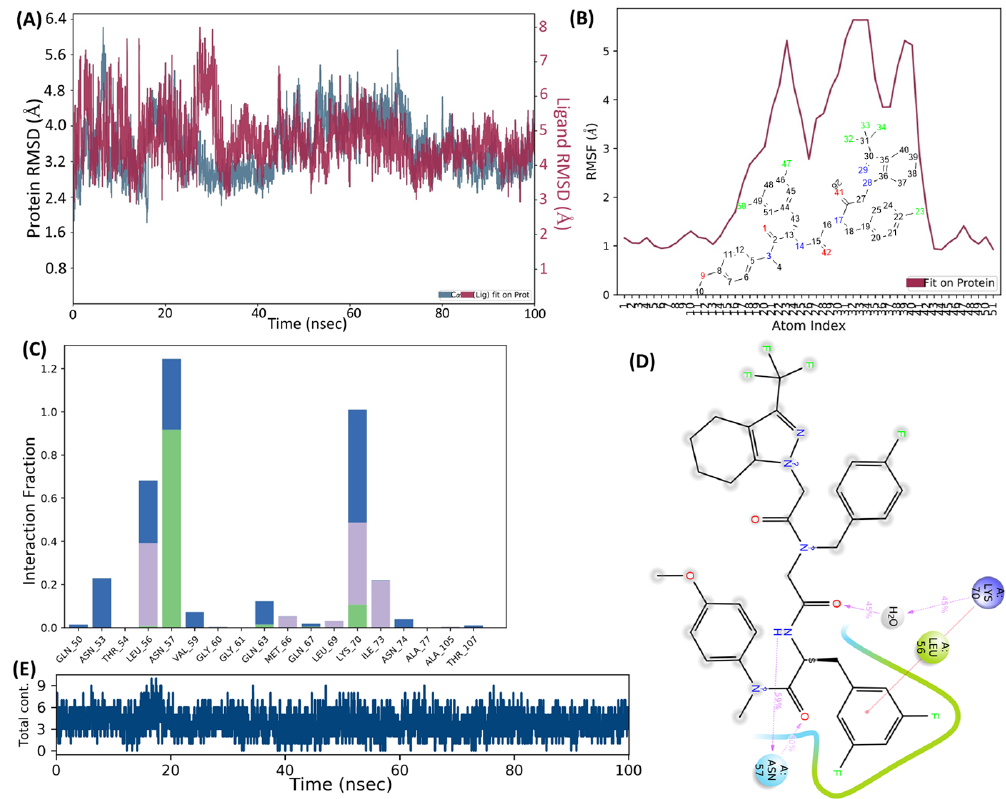
Figure 5. Molecular dynamics simulation of the I-19 complex with HIV-1 CA. ( A ) RMSD plot for Cα of capsid protein (PDB code: 5TSX) in complex with I-19 ; ( B ) RMSF plots of compound in the CA- I-19 complex; ( C ) The ratio of amino acid residues to the role of I-19 ; ( D ) The percentage of interactions in molecular dynamic simulations of I-19 complex with capsid; ( E ) A timeline representation of the interactions and total contacts (H bonds, hydrophobic interactions, and water bridges) obtained during the molecular dynamics simulations. The panels show the total number of specific contacts the capsid made with the I-19 throughout the